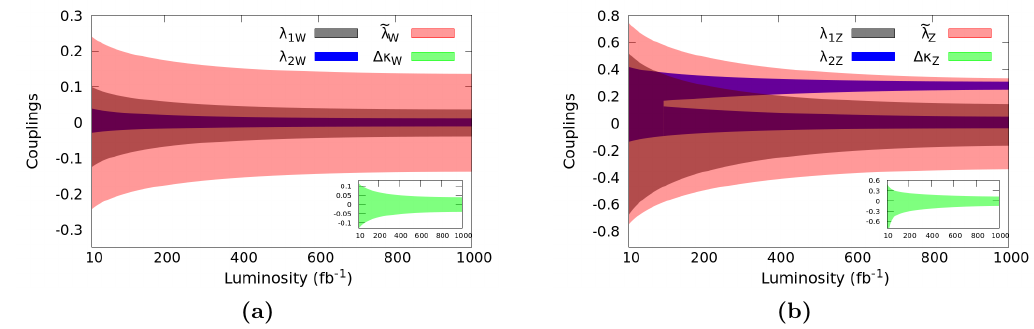
Figure 7 . Luminosity vs BSM coupling parameters (a) CC process (b) NC process.